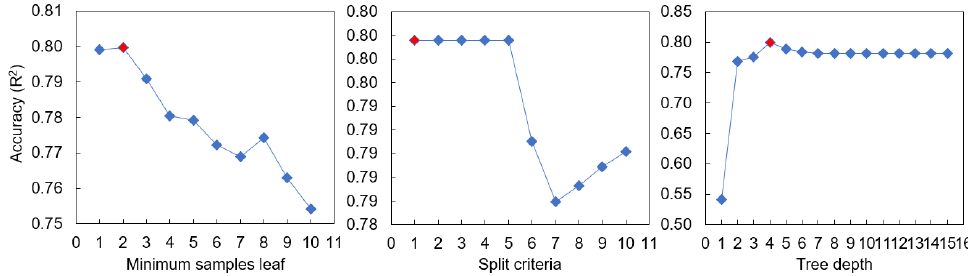
Figure 3. Linear regression model performance according to hyperparameter values. ( a ) Ridge, ( b ) Lasso, and ( c ) Elastic net regularization. The red diamond represents the hyperparameter value representing the optimal performance.